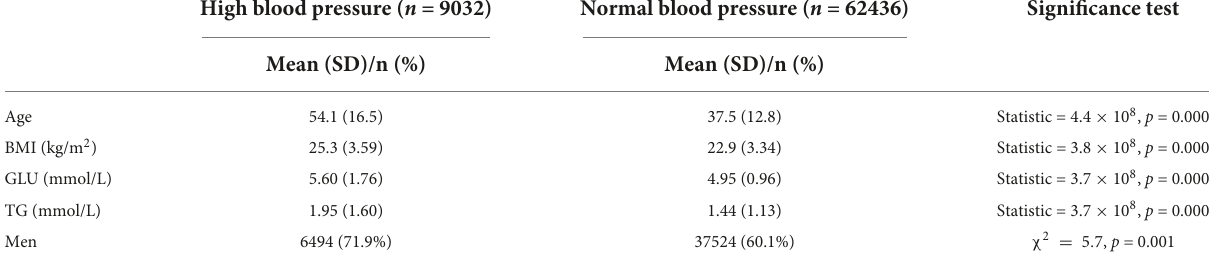
TABLE 1 Characteristics of research samples.